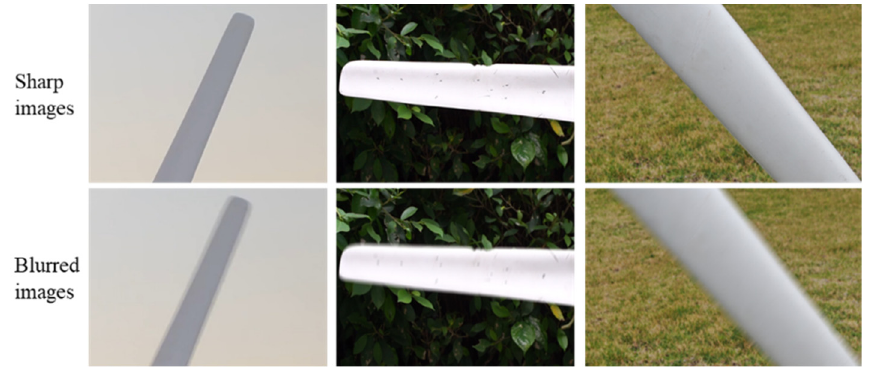
Figure 5. Three example images from dataset #2.